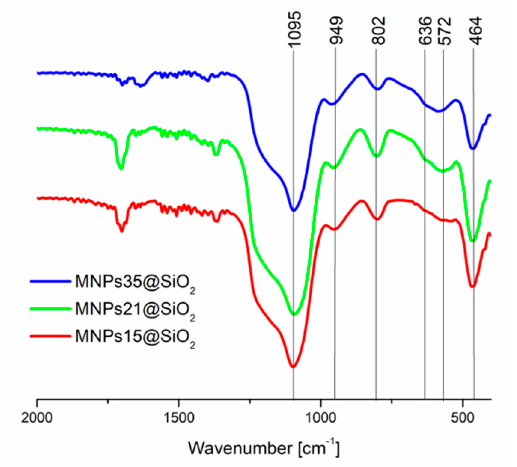
Figure 2. Fourier transform infrared (FT-IR) spectra of the magnetic nanocomposites.